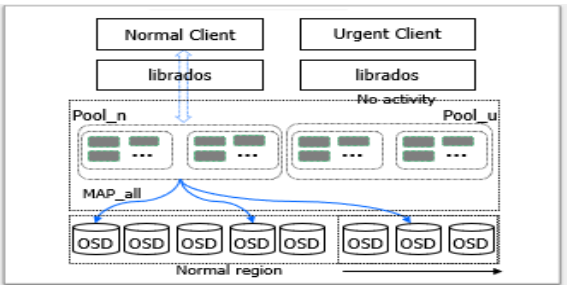
Figure 6. Shared mode: all OSDs are used for normal clients when there is no urgent client.